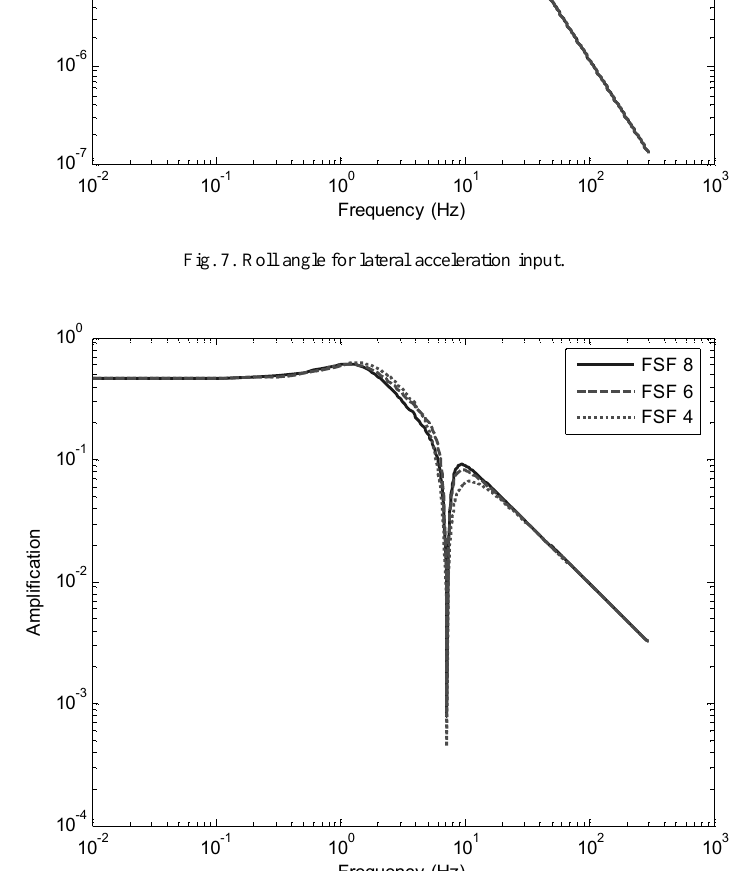
Fig. 8. Angular acceleration for lateral acceleration